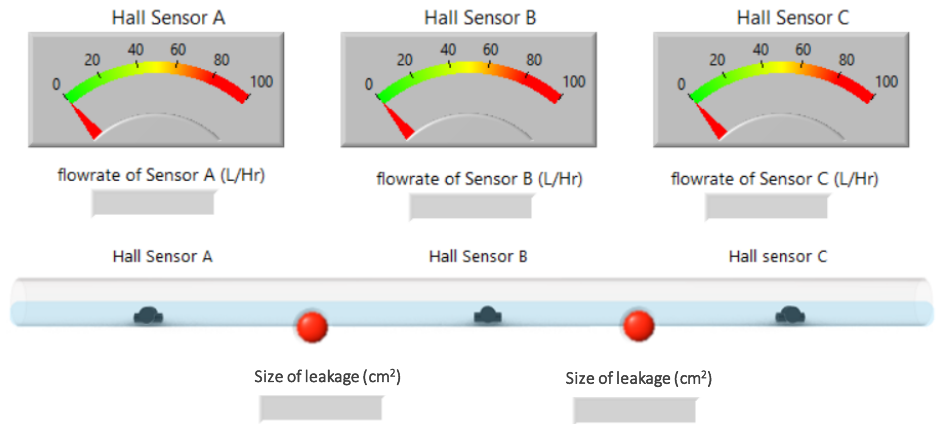
Figure 2. Human-machine interface of subsea pipeline detection system.